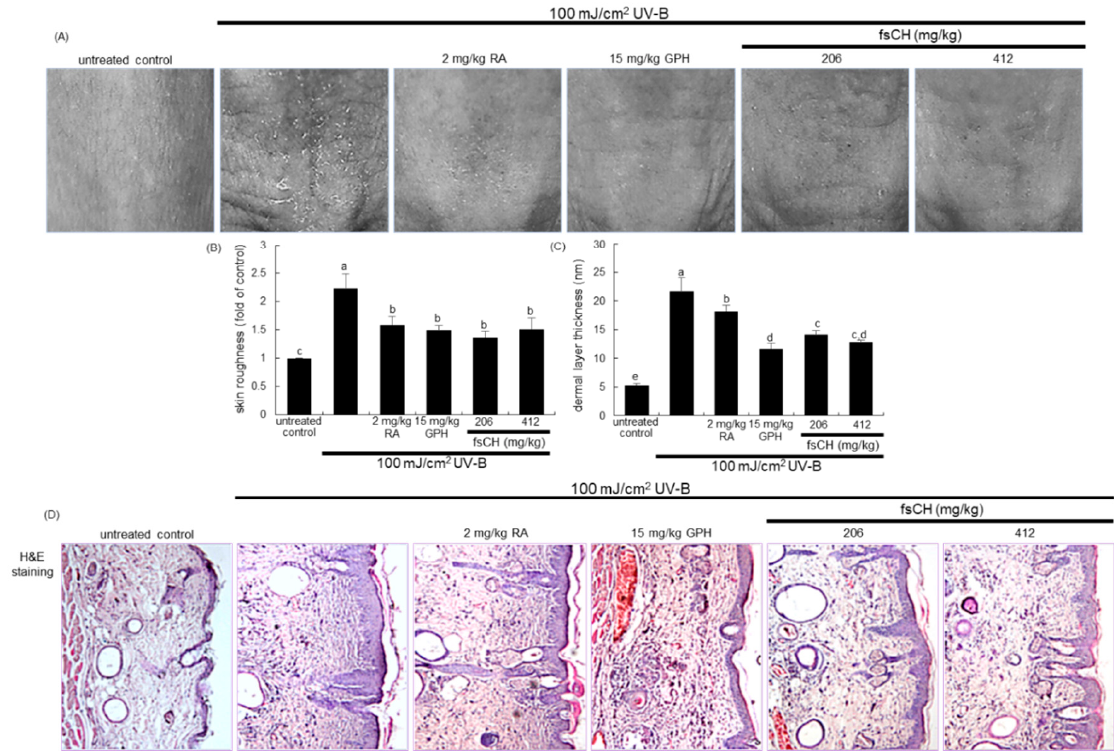
Figure 5. Wrinkle formation ( A ), skin roughness ( B ), dermal layer thickness ( C ), and dermal morphology ( D ) of SKH-1 hairless mouse dorsal skin. SKH-1 hairless mice were exposed to ultraviolet-B (UV-B) three times a week and treated with 2 mg/kg retinoic acid (RA) intraperitoneally and with 15 mg/kg glycine-proline-hydroxyproline tripeptide (GPH) and 206–412 mg/kg Pangasius hypophthalmus fish skin hydrolysates (fsCH) orally for eight weeks. Skin wrinkle images were photographed by using skin visiometer ( A ), and skin roughness and dermal layer thickness were measured from photographs by microscopic analysis (mean ± SEM, n = 5) ( B , C ). Respective values in bar graphs not sharing a small letter are different at p < 0.05. For the morphometric analysis of skin, dermal tissue sections were stained with H&E ( D ). Each photograph is representative of five mice.